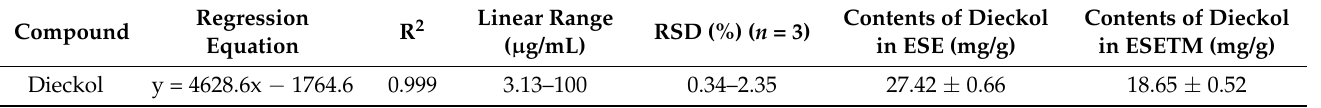
Table 1. The regression data, precision and quantification of the ESE and ESETM.